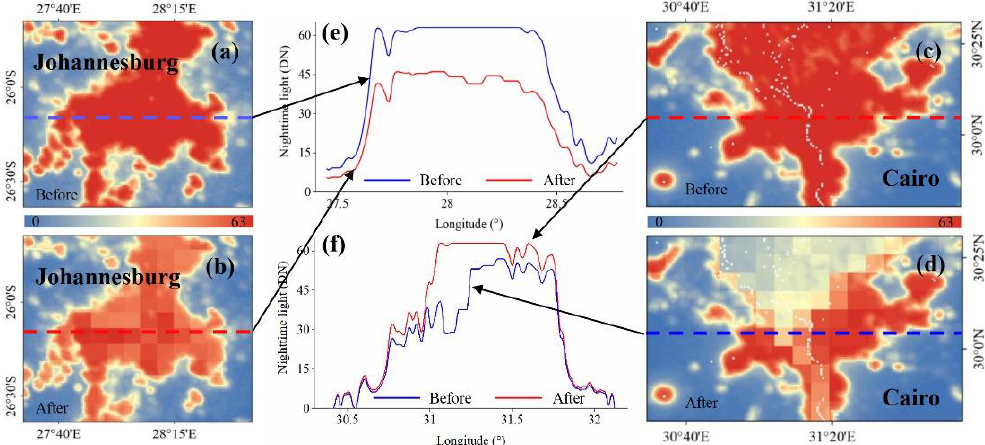
Figure 5. ( a , c ) Nighttime light before NDVI-induced calibration of Johannesburg and Cairo, respectively; ( b , d ) after the enhancement of variability using NDVI over Johannesburg and Cairo, respectively; ( e , f ) latitudinal transects of nighttime light across Johannesburg and Cairo, respectively.